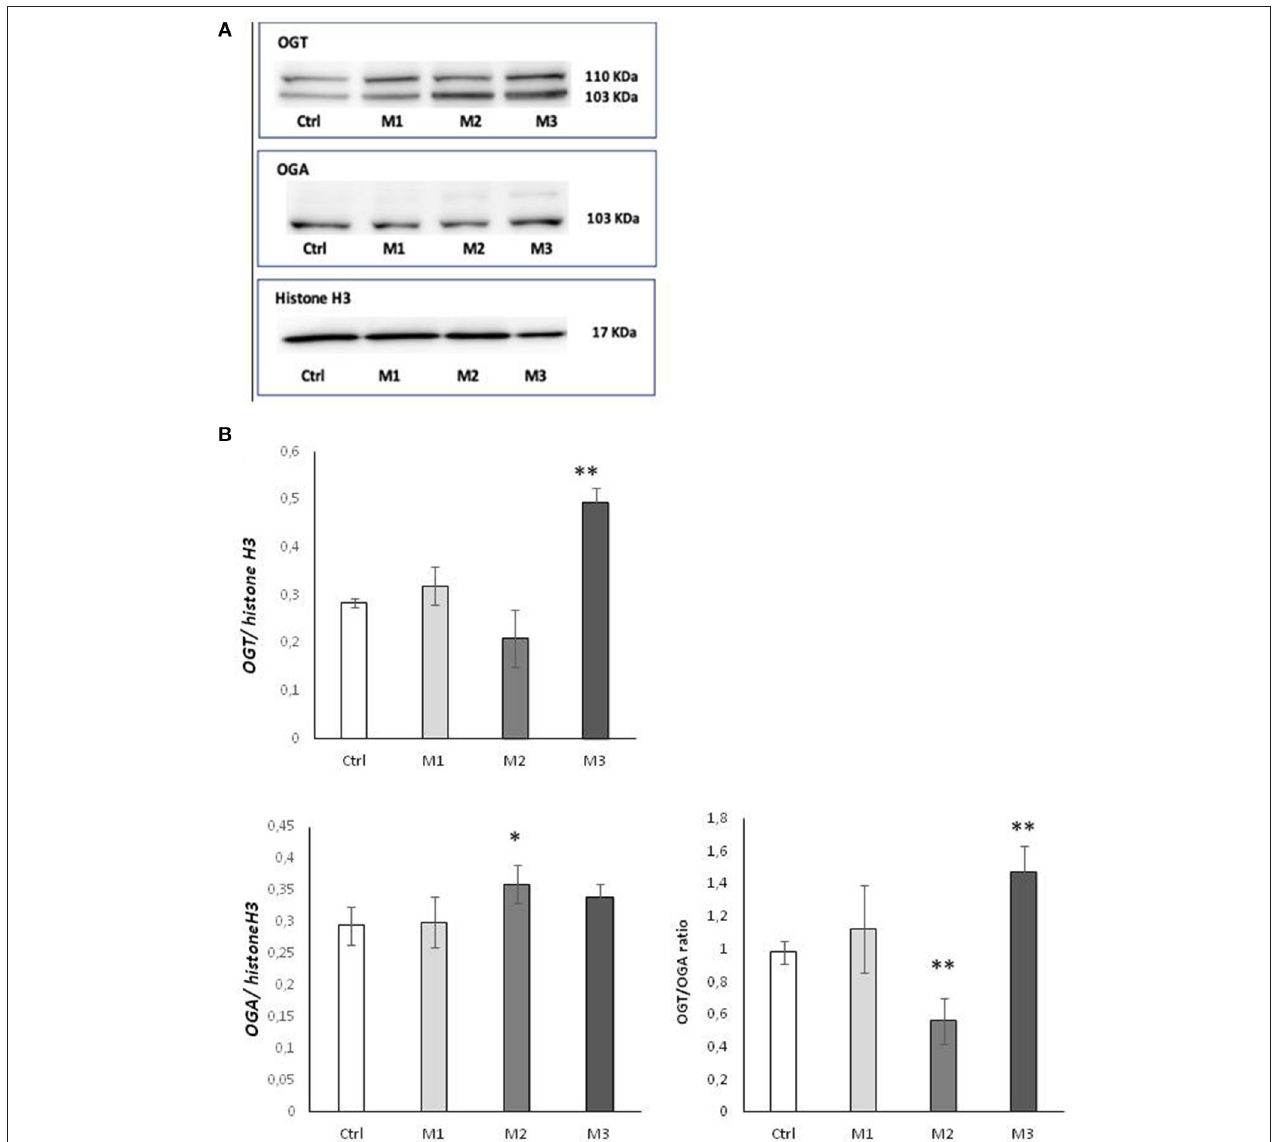
FIGURE 2 | OGA and OGT levels after exposure to M1, M2, and M3 wear debris. (A) Cellular levels of OGA and OGT proteins examined by western blotting. The western blot image is representative of three experiments. Densitometric analysis of proteins expression was performed using Histone H3 as loading control. (B) OGT/OGA expression ratio. * P < 0.05 Vs. Ctrl; ** P < 0.01 Vs. Ctrl. Materials M1, M2, M3 are described in the Methods section, as follows: Material M1a moderately cross-linked vitamin E-blended UHMWPE, EtO sterilized; Material M2 standard UHMWPE (without vitamin E and not cross-linked), EtO sterilized; Material M3 vitamin E-blended UHMWPE not cross-linked, EtO sterilized. Control (white bar) Material M1 (light gray bar), material M2 (medium gray bar), material M3 (dark gray